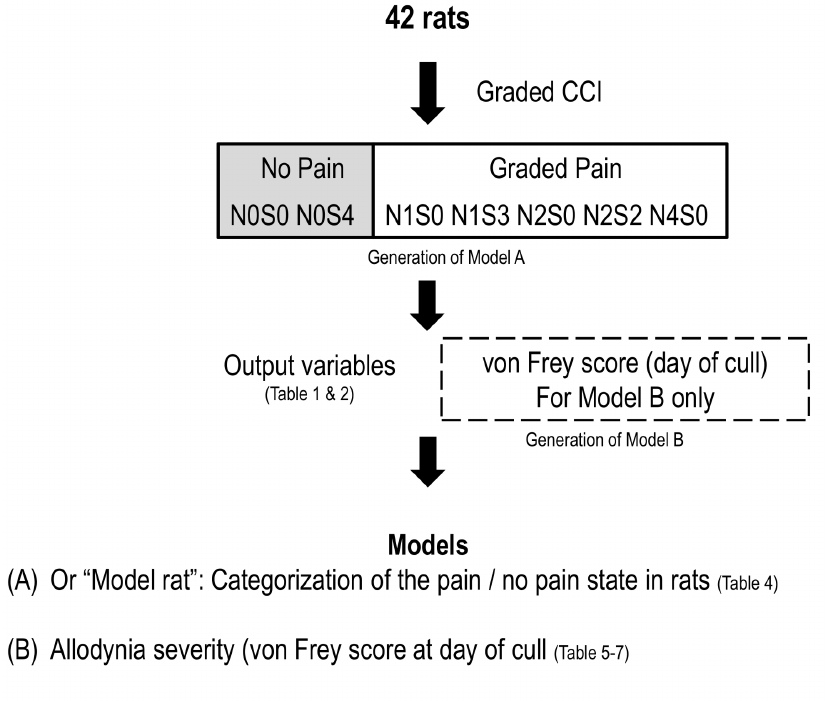
Figure 1. Overview of the generation of models in post graded CCI rats.